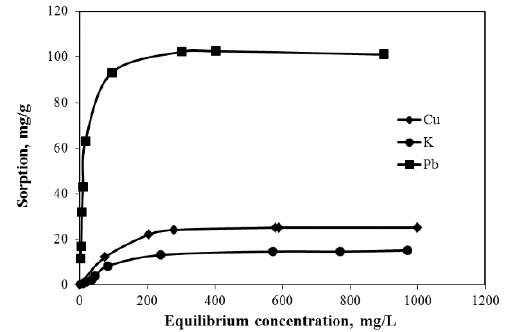
Fig. 1. Adsorption isotherms of Cu, K and Pb.